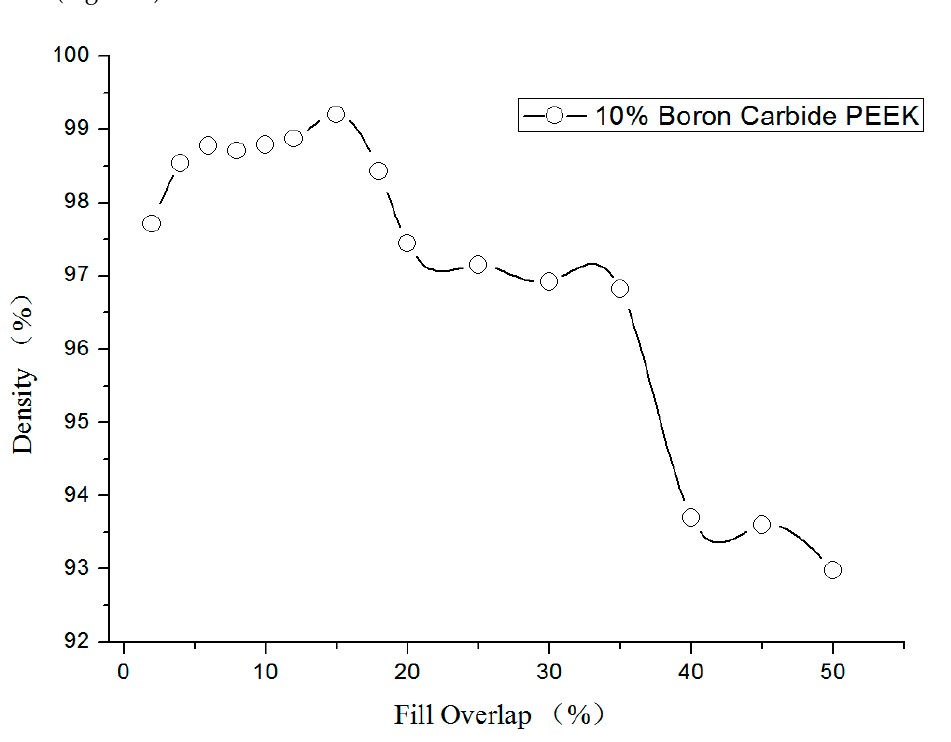
Figure 4. Relationship between the overlapping ratio of filling lines with density.